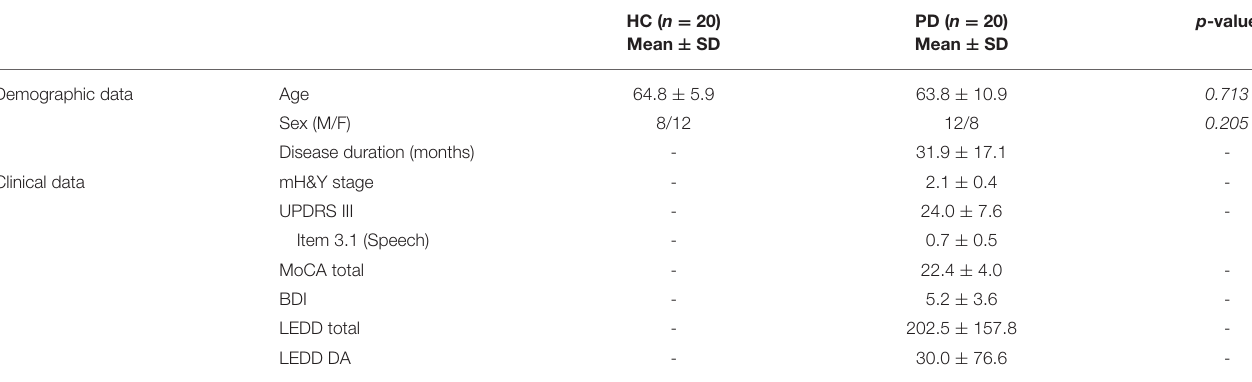
TABLE 1 | Demographic and clinical features of patients with PD and